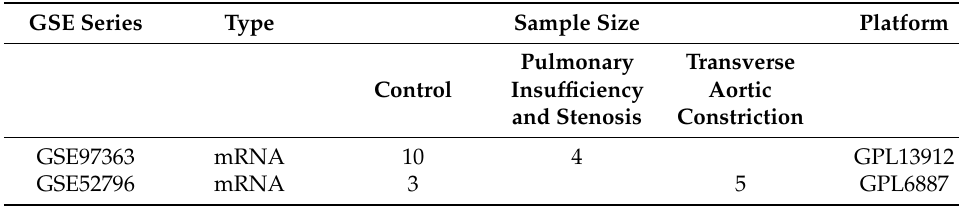
Table 1. Basic information of GEO datasets used in the